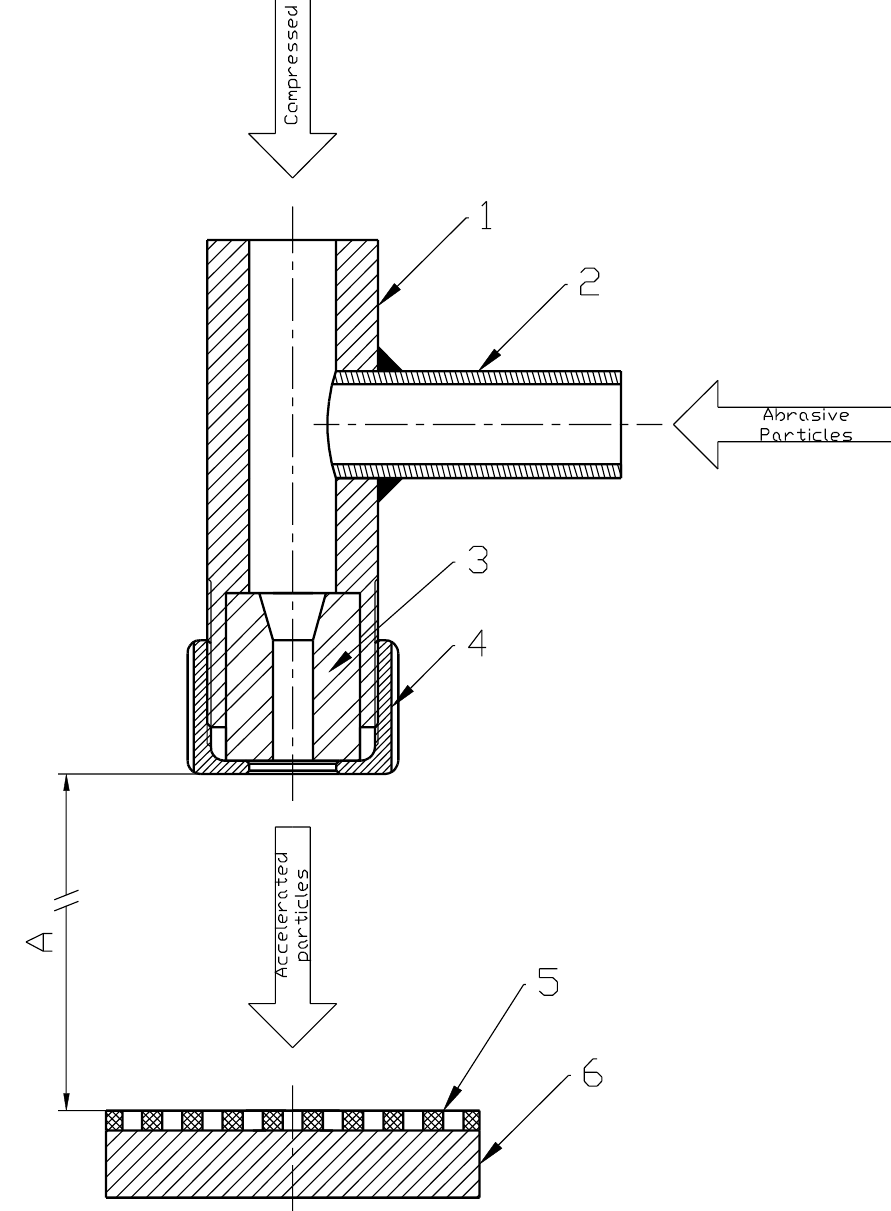
Figure 3. Scheme of surface texturing by abrasive jet machining method.